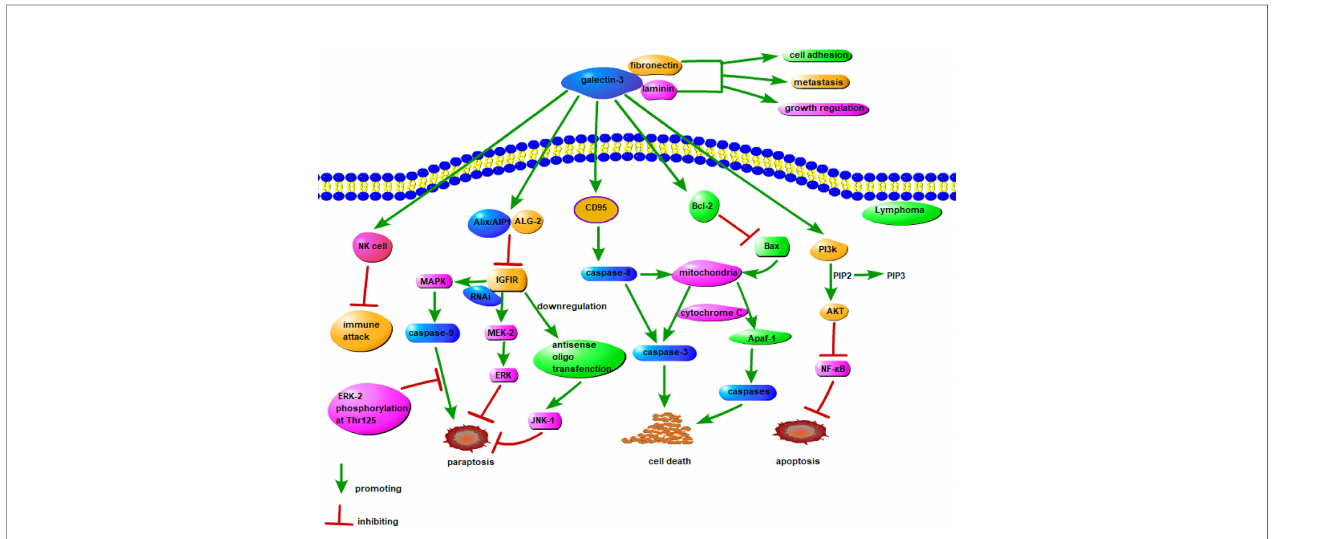
FIGURE 2 | Possible mechanism of galectin-3 in lymphoma. Insulin-like growth factor I receptor (IGFIR) triggers the involvement of at least two signaling pathways, namely the MAPK/ERK and JNK pathways, leads to paraptosis. Both pharmacological inhibition of MAPK and downregulation of MEK-2 by RNAi, as well as downregulation of JNK1 by antisense oligo transfection, inhibites paraptosis. Among them, caspase-9 is a direct target of MAPK, and the phosphorylation of ERK-2 to Thr125 inhibits the pro-apoptotic activity of caspase-9. Galectin-3 inhibits IGFIR in combination with Alix/AIP1, thereby modulating paraptosis. The combination of galectin-3 and CD95 stimulates the activation of caspase-8 and interferes with the apoptotic signaling pathway from caspase-8 to mitochondria, and it can also combine with Bcl-2 to stimulate Bax and interfere with the apoptosis signaling pathway of mitochondrial Apaf-1. Galectin-3 can also inhibit apoptosis through PI3K/ AKT/NF- k B signaling pathway. The combination of galectin-3 with NK cells may have the effect of suppressing immune attack, and the combination with fi bronectin and laminin can promote tumorigenesis in